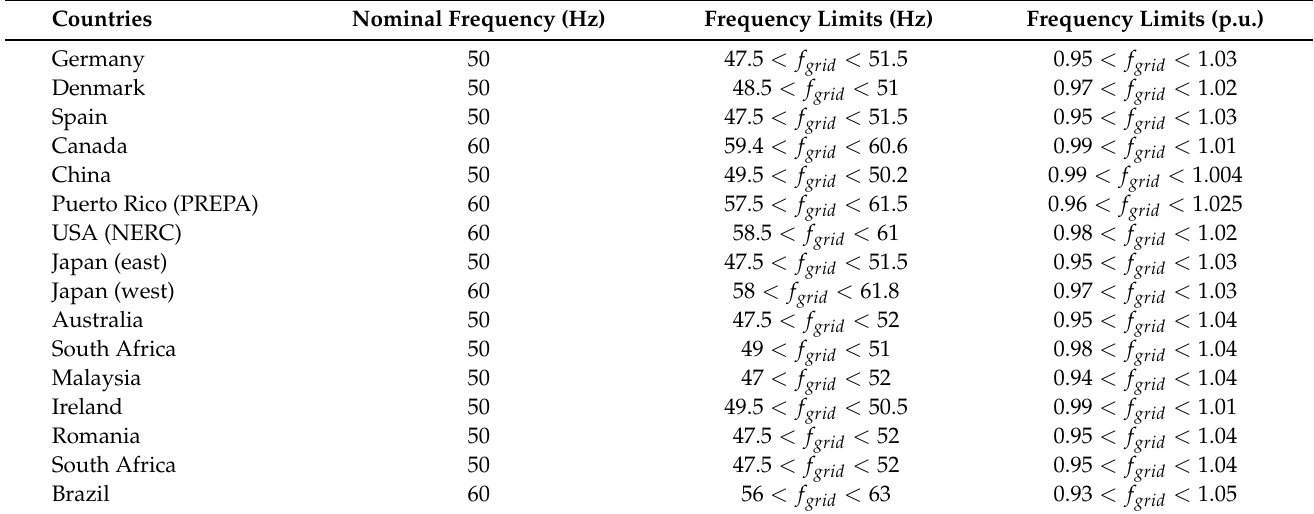
Table 6. Frequency limits as established in the operation of various countries’ electrical